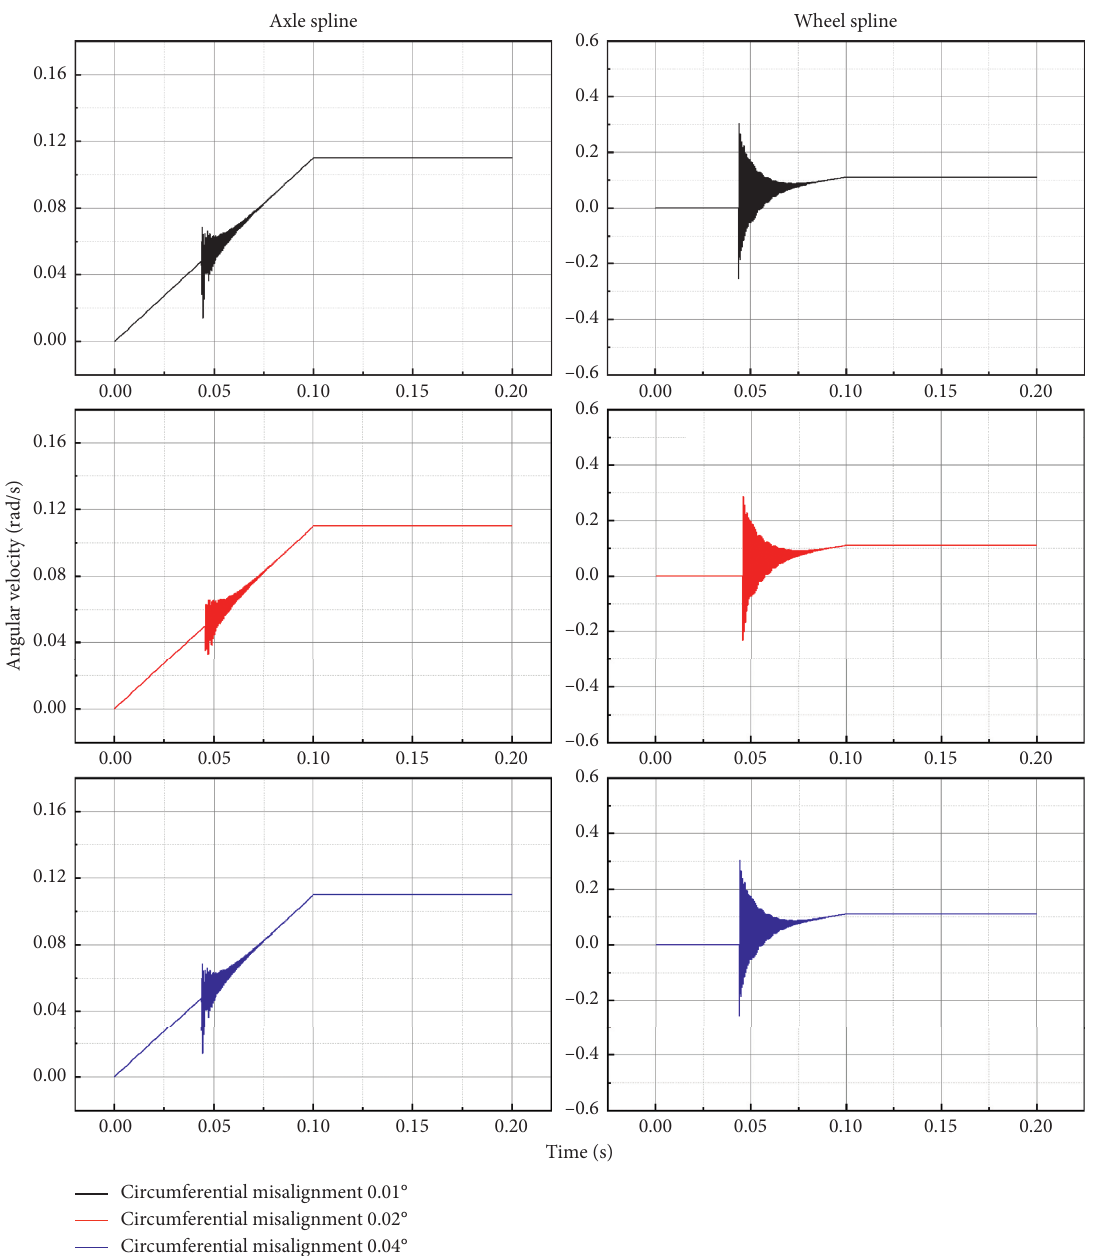
Figure 20: The comparison of angular velocity of spline coupling with different circumferential misalignments φ under identical loading